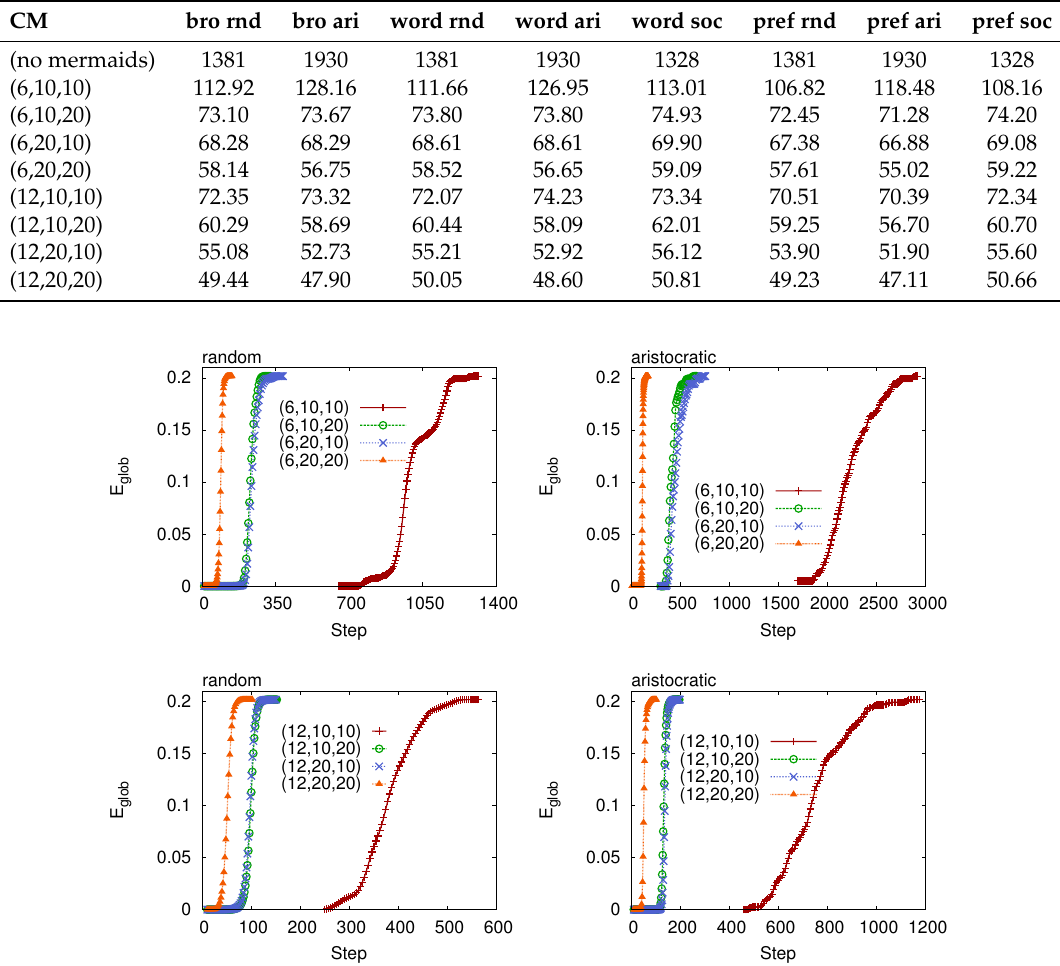
Table 5. Summary of the average T min in all configurations of the number of mermaids ( m ), attractiveness ( a ), and length of time ( d ) of accelerated analysis with and without mermaids. Mermaid’s dynamics are broadcast (bro), word of mouth (word) and preferential (pref), combined with users’ dynamics random (rnd), aristocratic (ari) and social (soc). Communities online social network.